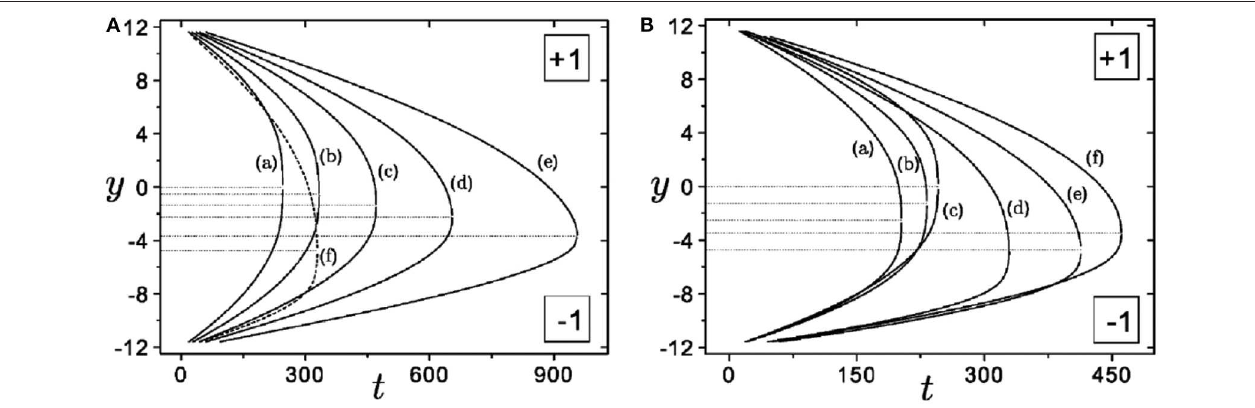
FIGURE 9 | Effect of elastic anisotropy (left) and flow parameters (right) on defect annihilation of a ( α 7 / 9 (e) α 15 / 17, (f) same as (d) in right image, for comparison. (B) (a) θ 1 = = π/ 2, α viscosity γ 1 doubled, (e) θ 1 0, α 2 / 3, (f) θ 1 2 / 3. Images reproduced from Svenšek and Žumer [55], copyright American Physical = = = = −